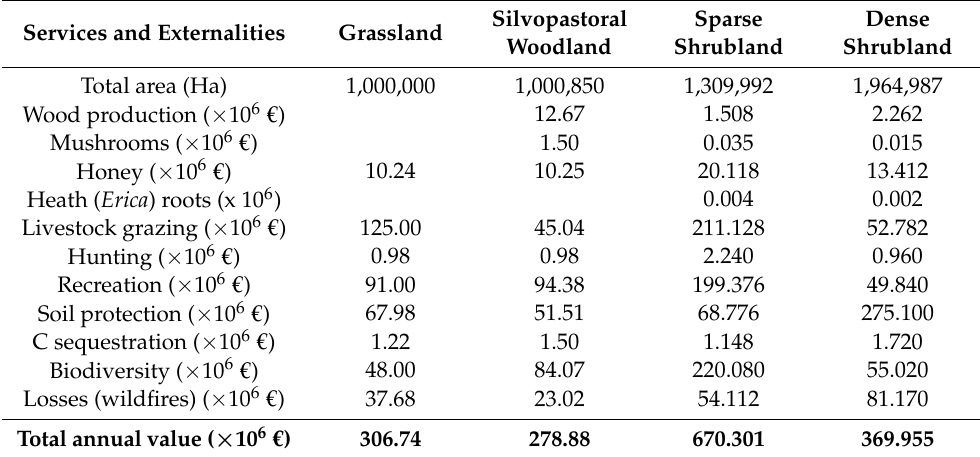
Table 4. Value (EUR) of grassland, silvopastoral woodland and sparse and dense shrubland per service and product.